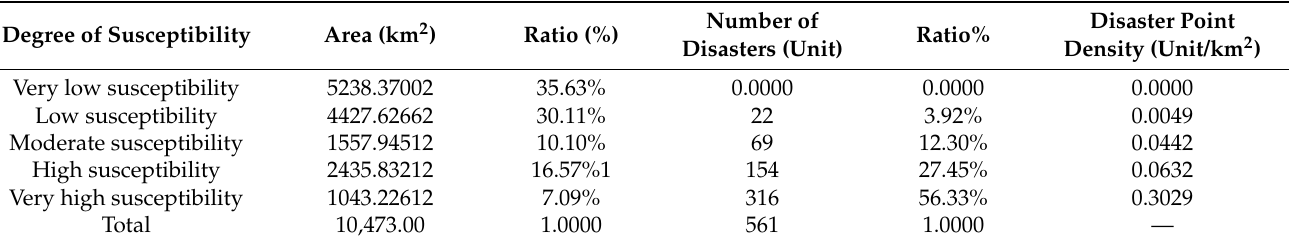
Table 6. Statistical table of CF + SVM model susceptibility.